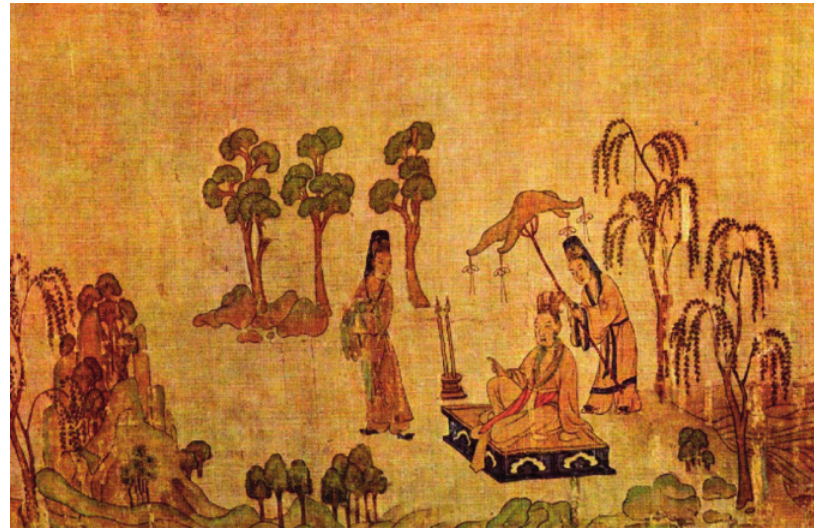
Fig. 2 . Gu Kaizhi. Nymph of the Luo